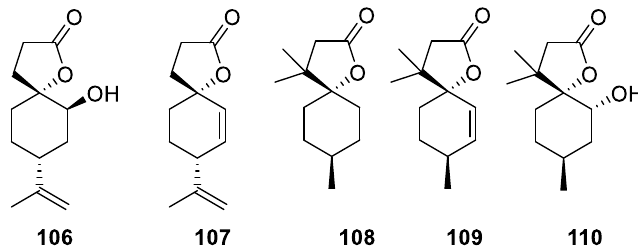
Figure 47. Pathylactone A isolated from marine sources.